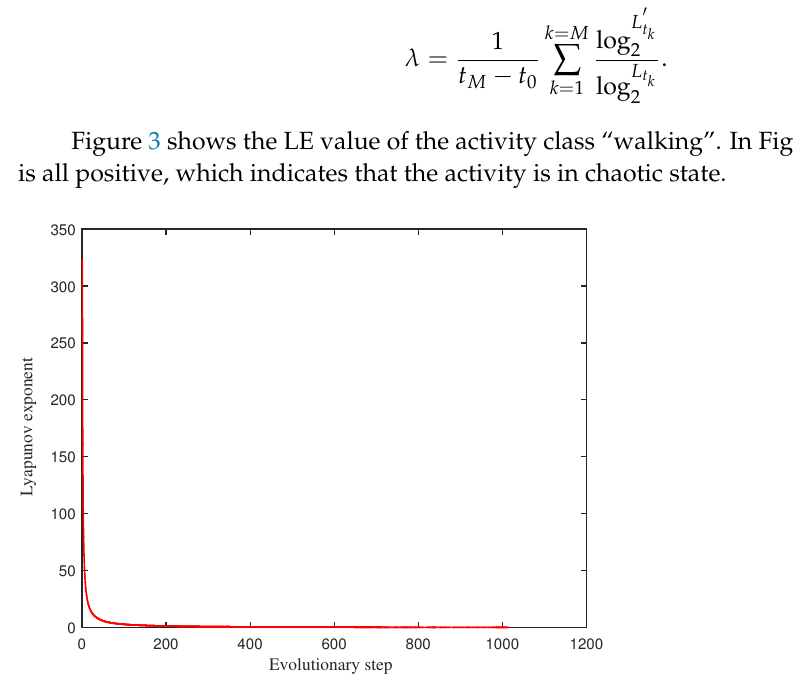
Figure 3. The Lyapunov exponent (LE) value of the activity class